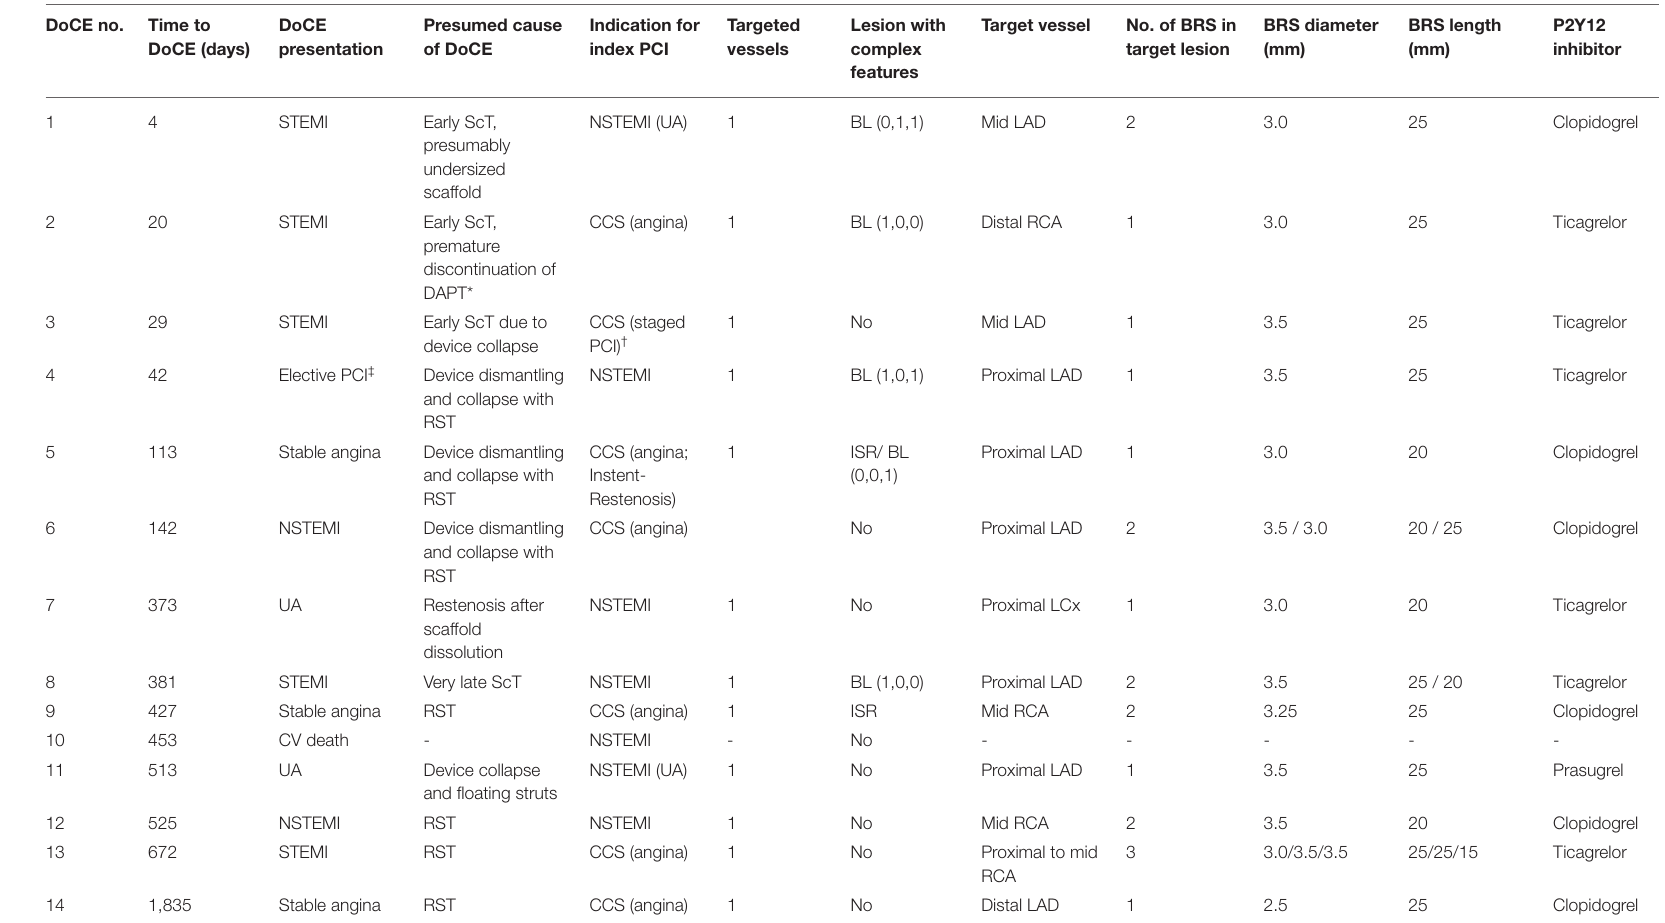
TABLE 4 | Narratives of the 14 patients with a